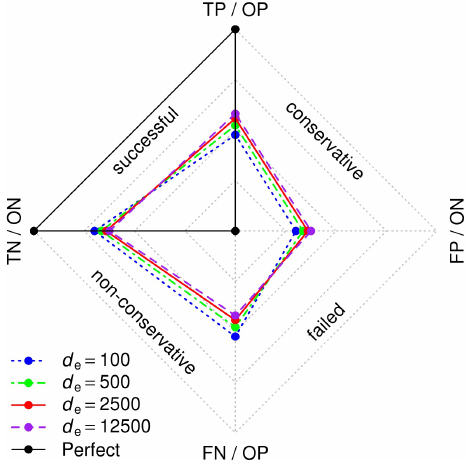
Figure 6. Influence of d e on the performance of r.slope.stability in terms of prediction rates, building on FoS. Pixels representing observed shallow landslide areas (observed positives, OP) with a modelled value of FoS < 1 represent true positive predictions (TP). OP pixels with FoS ≥ 1 represent false negative predictions (FN). Pixels not representing observed shallow landslide areas (observed negatives, ON) with a modelled value of FoS < 1 represent false positive predictions (FP). Finally, ON pixels with FoS ≥ 1 represent true negative predictions (TN).